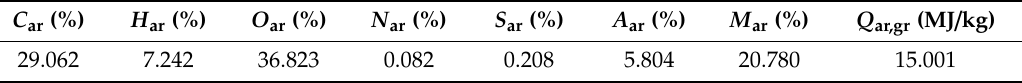
Table 1. Waste liquor elemental analysis and heat value.